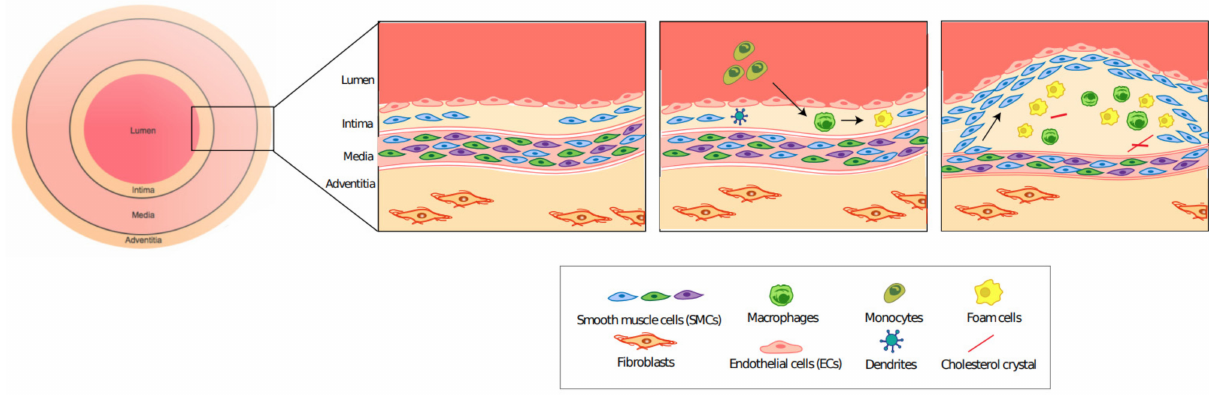
Figure 2. Plaque formation in atherosclerosis. Endothelial cell dysfunction leads to the recruitment of circulating monocytes, which become macrophages. Macrophages phagocytose oxLDLs to form foam cells. This inflammatory process stimulates the migration of SMC from the medial wall to form the fibrous